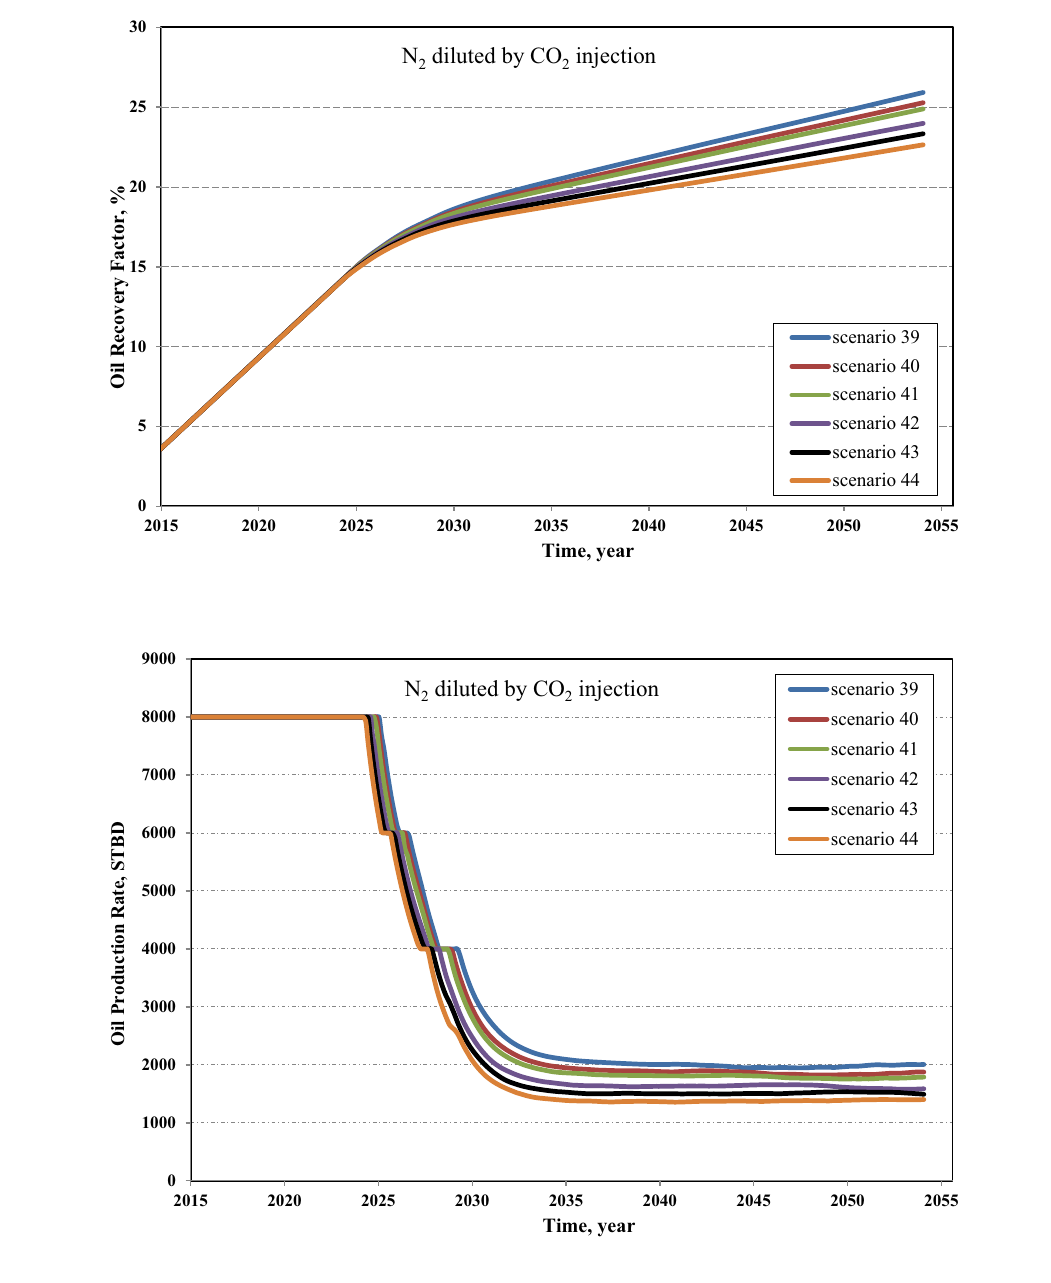
Fig. 15 Oil recovery factor for 50% N 2 –50% CO 2 mixture into different reservoir layers